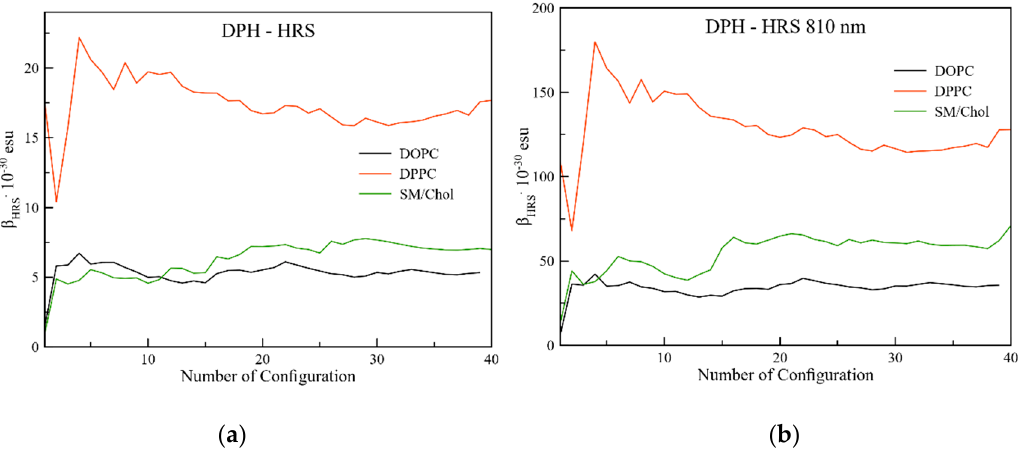
Figure 4. ( a ) Static and ( b ) dynamic components of the hyper-Rayleigh scattering.